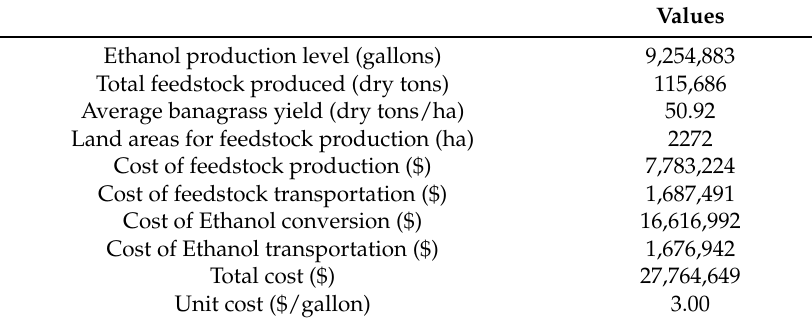
Figure 5. Spatial distribution of selected ethanol processing site and banagrass production land areas to meet the ethanol production level of 2% of the state’s highway fuel demand for 2020. Table 6. Banagrass yield increase to equal the average imported price in Hawaii to meet 2% of the state’s highway fuel demand.